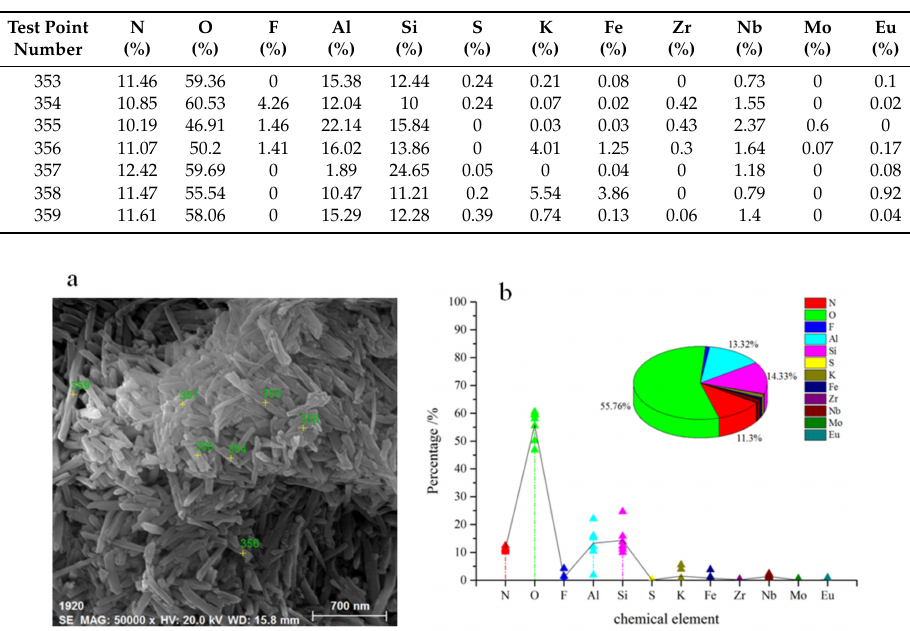
Table 5. The weight percentages of elements contained in each test point.